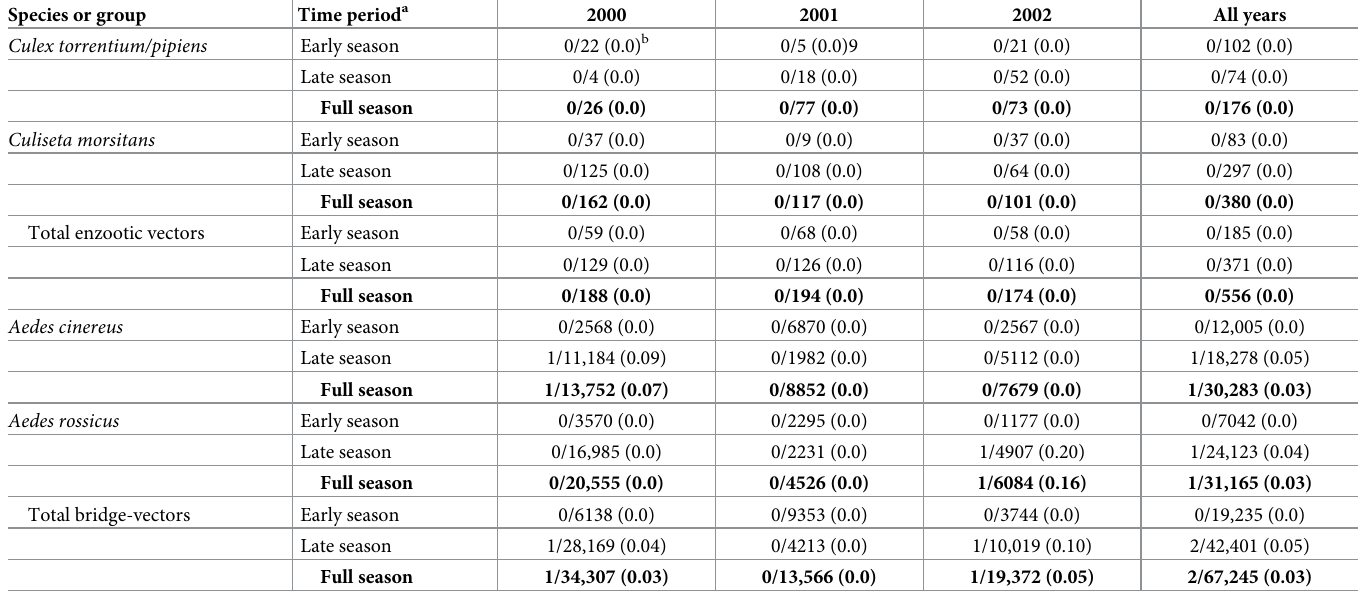
Table 3. Sindbis virus infection rates in monthly samples of vector mosquito species collected in the River Dala¨lven floodplains, central Sweden, during 2000 until 2002. Species or